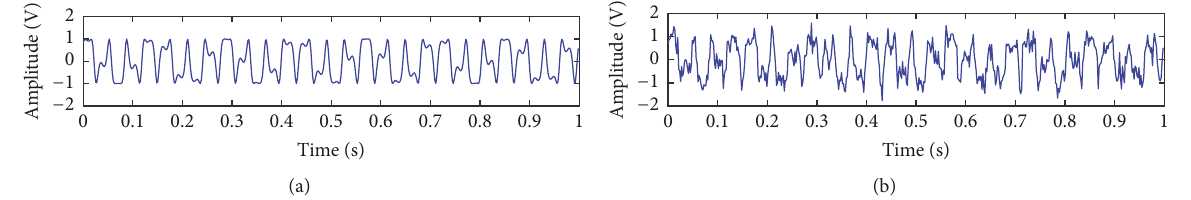
Figure 1: The waveform of simulated signal: (a) pure signal waveform 𝑆 1 (𝑡) and (b) noisy signal waveform 𝑆(𝑡) .